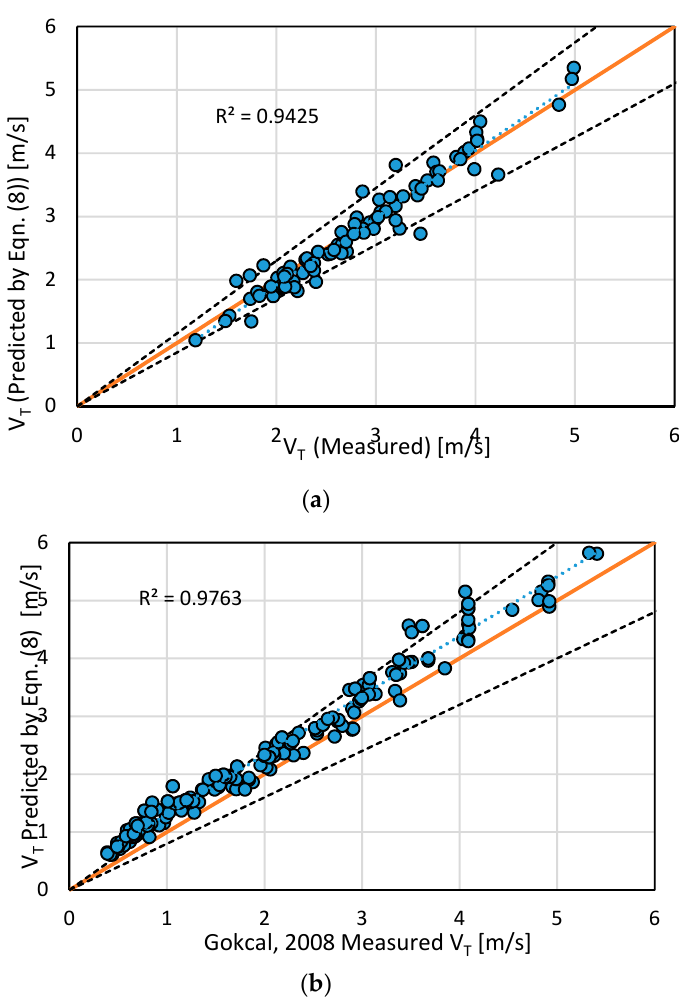
Figure 9. ( a ) Cross plot of the new correlation’s prediction against the experimentally measured slug body translational velocity (Equation (8)). The error bands are ± 15% limits of deviation between experiments and predicted points. ( b ) Cross-plot of the model prediction (Equation 8) vs. the experimental measurements of Gokcal [9]. Error bands represent ± 15% deviation of the model from the experimental slug translational velocities.